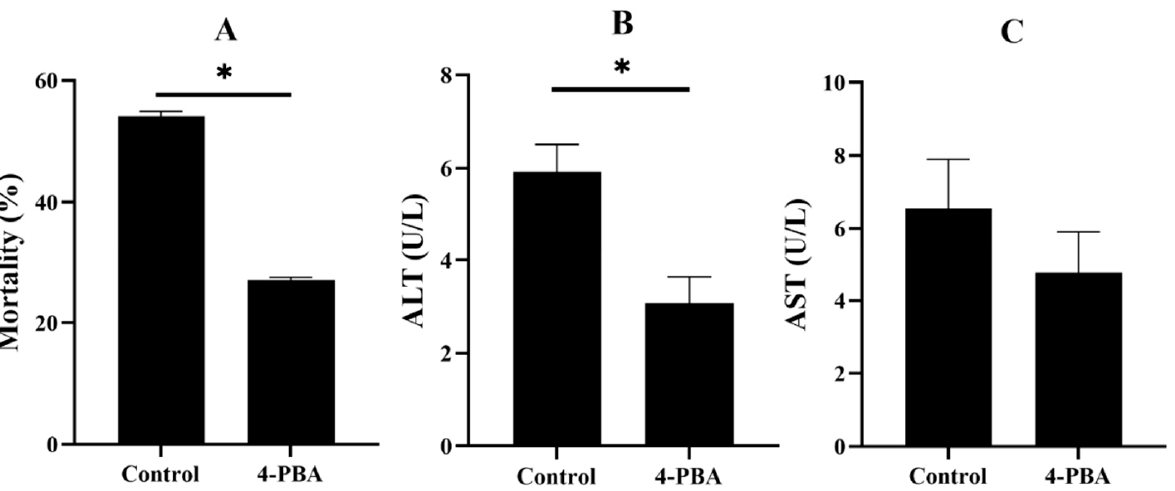
Figure 6. Mortality ( A ) and serum alanine aminotransferase ( B ) and aspartate aminotransferase ( C ) activities of L. maculatus after two weeks of being fed the test diets and 48 h of ammonia nitrogen exposure. All values are exhibited as mean ± SE. The values with different superscript (*) are significantly different at p < 0.05 (Student’s t -test).